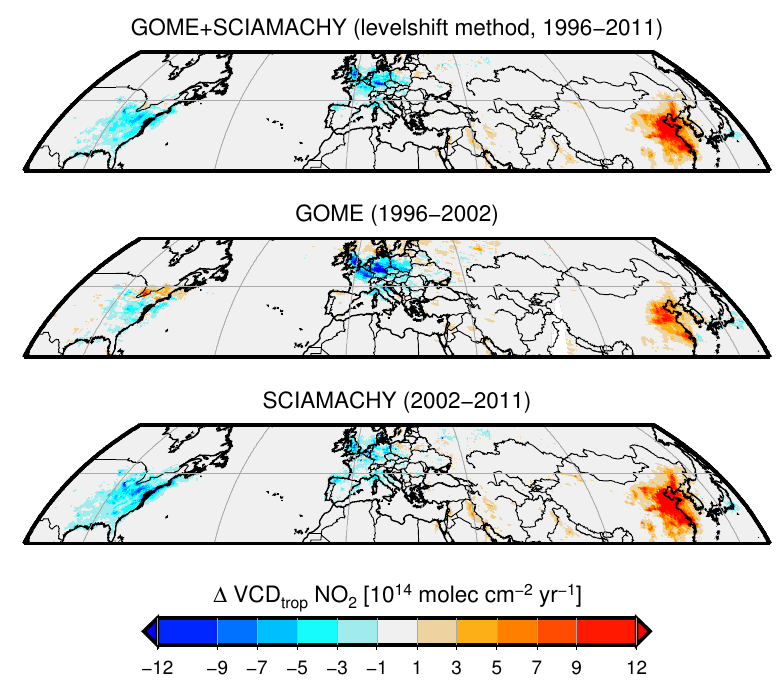
Fig. 16. Slope ω of the level shift model (Eq. 3, top) and of the seasonality model (Eq. 3 without the level shift terms δU(t) and (γ − 1 )U(t) ), applied to monthly averages of GOME (centre) and SCIAMACHY (bottom) measurements alone. All data have been gridded to 0.25 ◦ before performing the model fit. In contrast to Fig. 15, statistically insignificant trends have not been masked